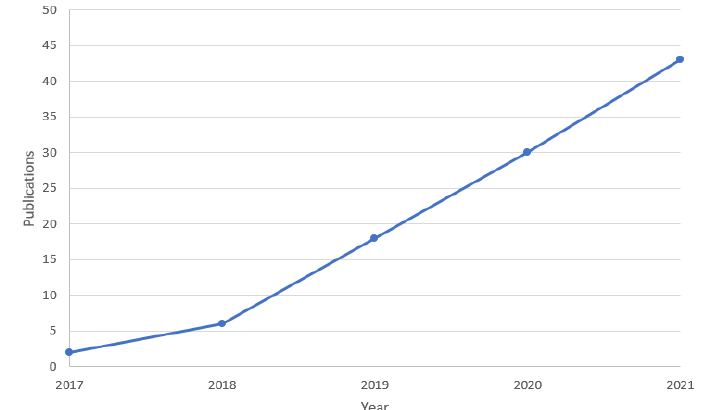
Figure 2. The resultant publications in the most recent five years retrieved from SCOPUS with the adopted search string